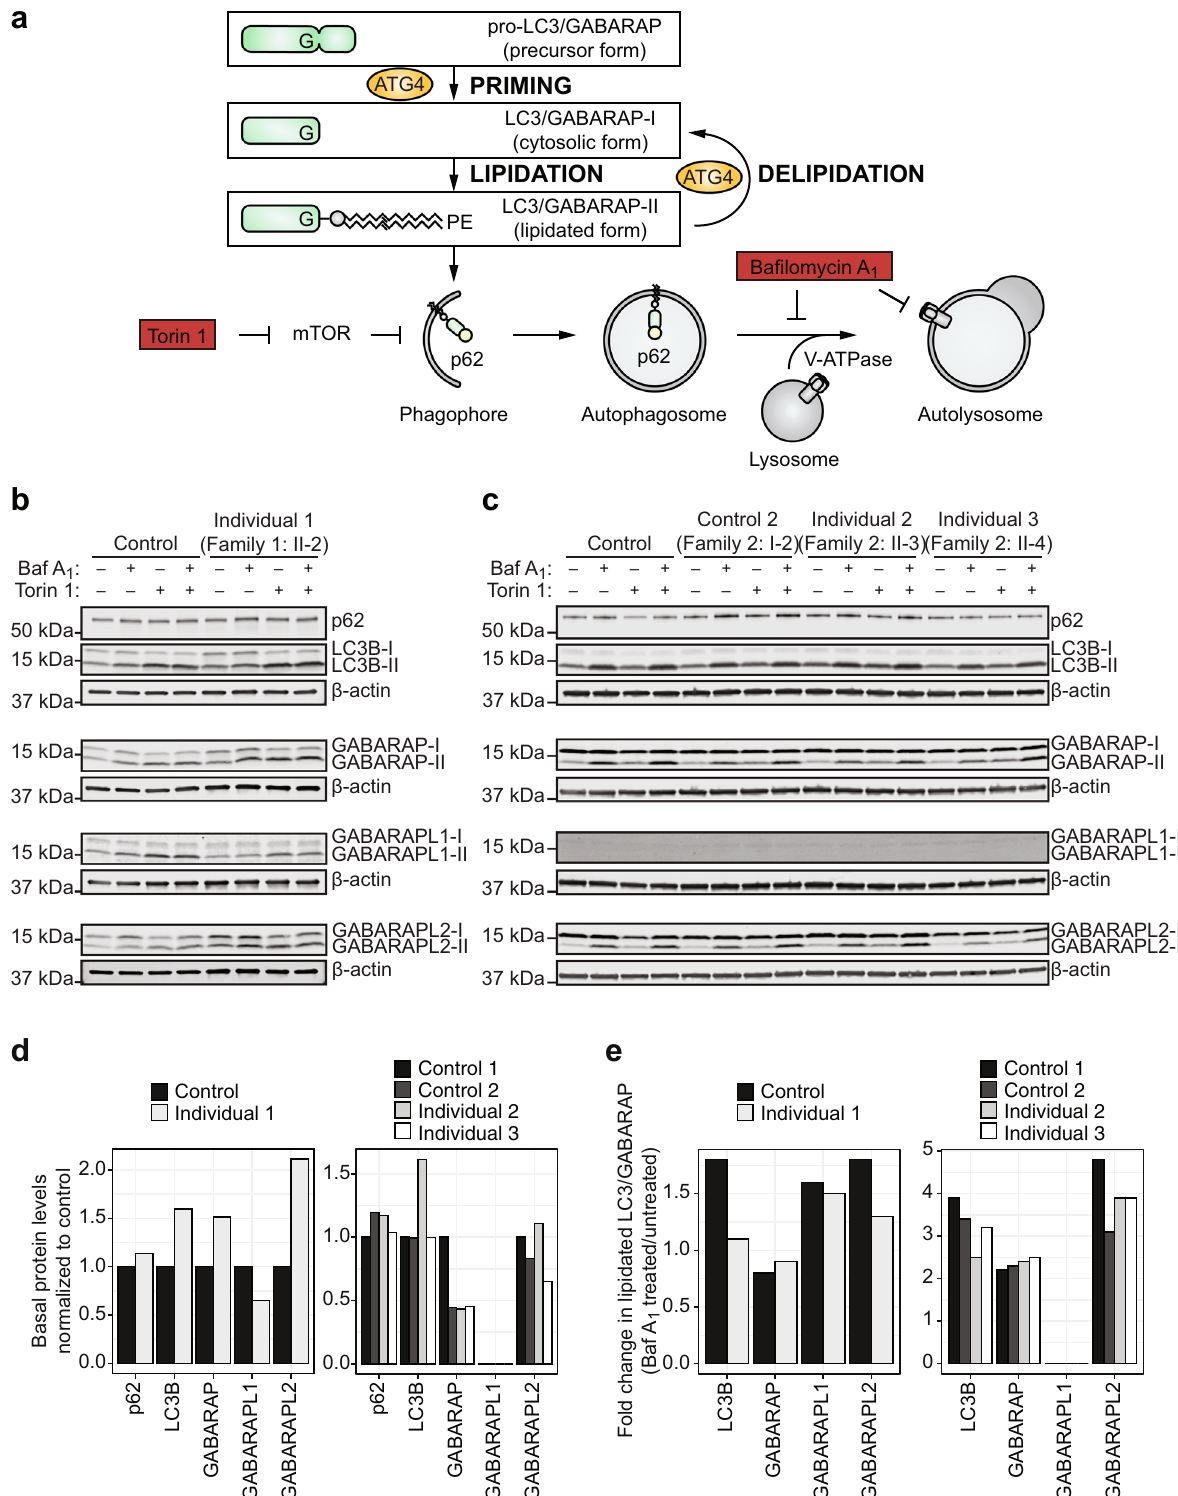
These observations suggest that the variability in the clinical presentation, disease progression, and neuroimaging in the three affected individuals presented here may not be unexpected. Continued clinical follow-up will be needed to clarify disease progression for these individuals with bi-allelic variants in ATG4D